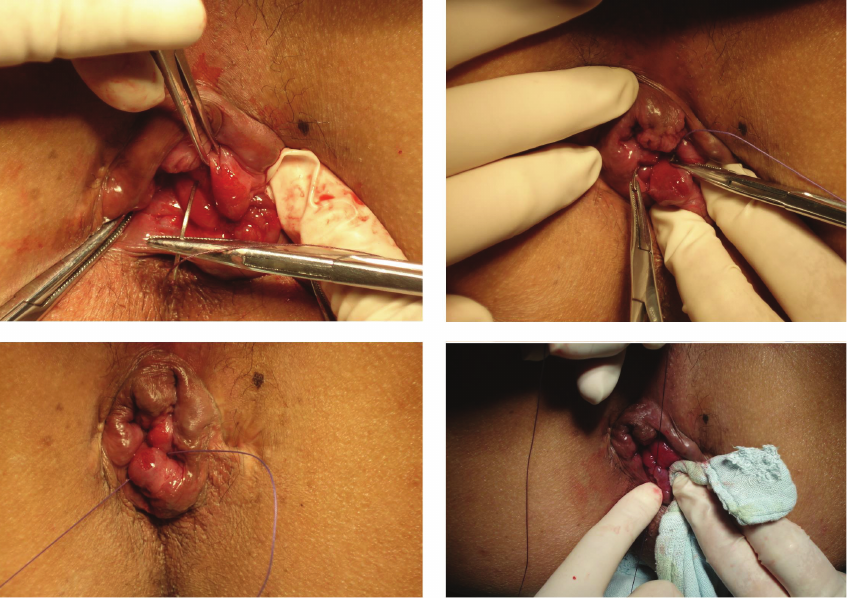
Figure 2: Procedure of suture-fixation